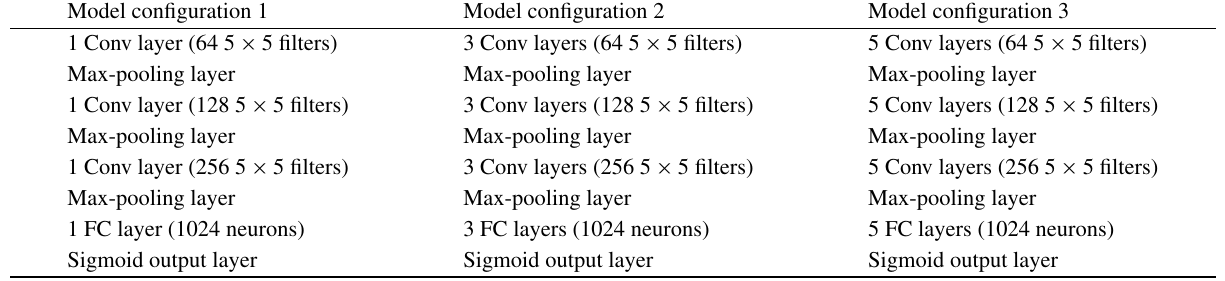
Fig. 6 TPR and ACC for different feature sets in the ISCX2012 dataset. Table 1 Model configurations of convolutional neural network.